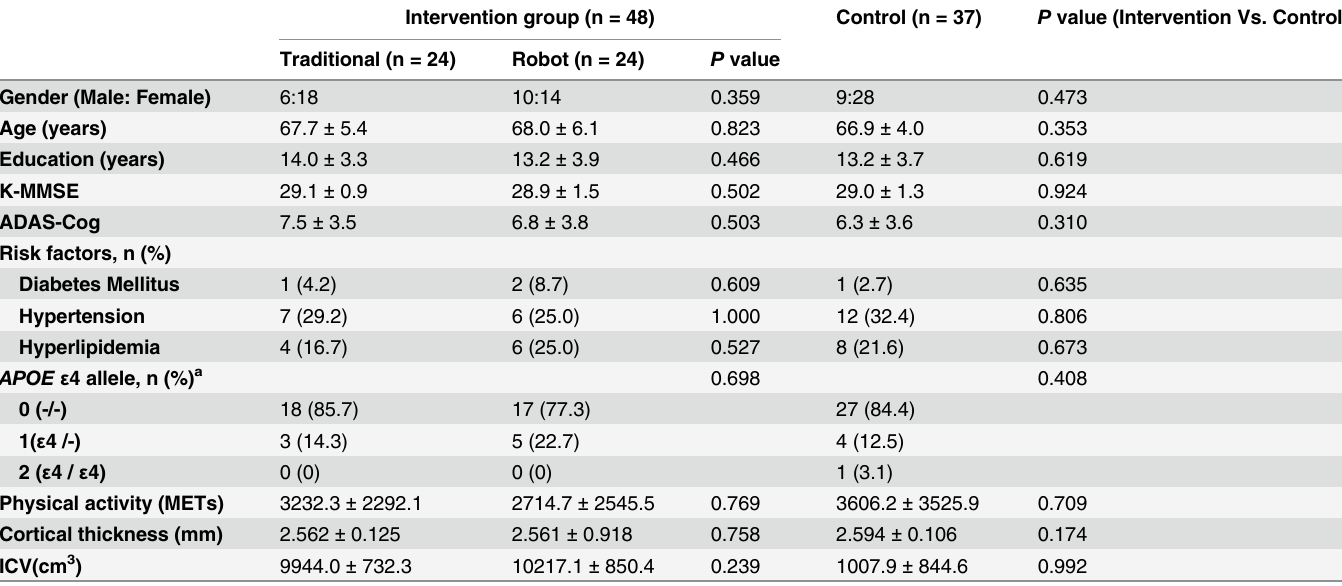
Table 1. Demographic and clinical characteristics of the